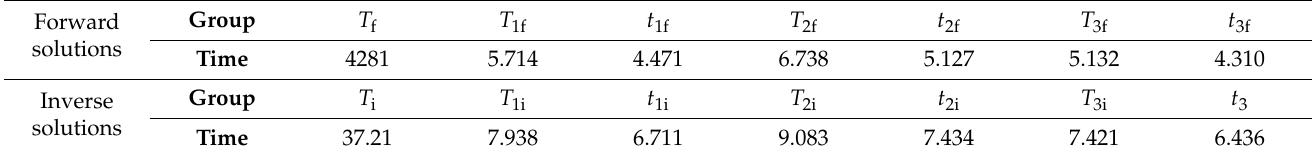
Table 8. Calculation time of different formulas (unit: